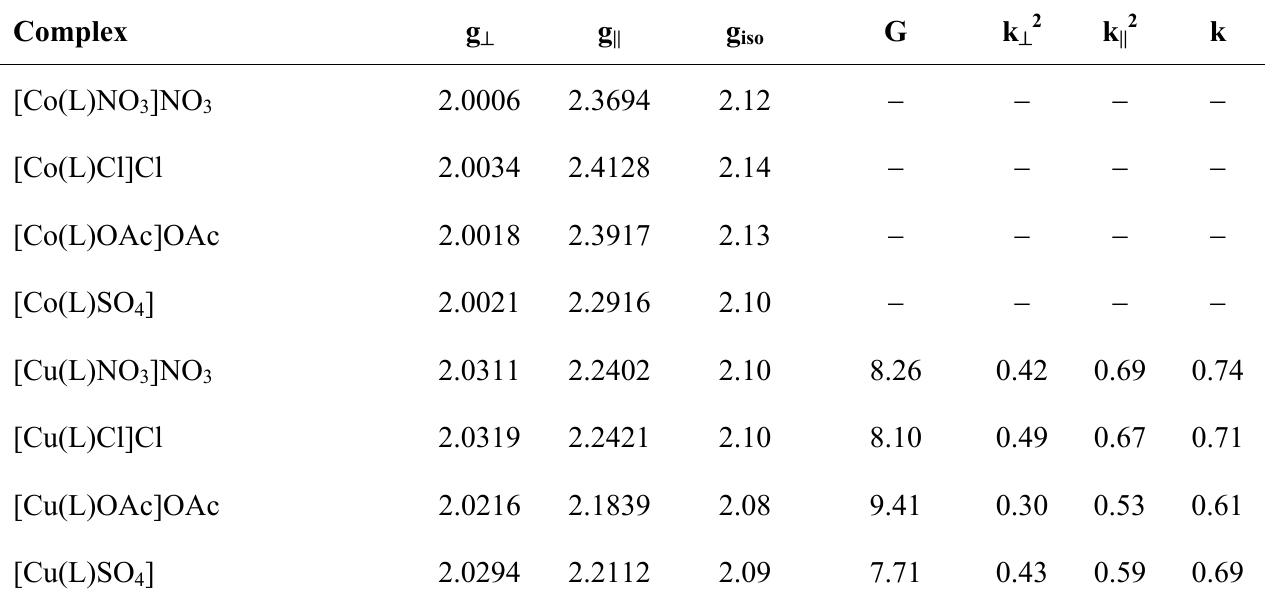
Table 5. EPR parameters and orbital reduction parameters of Co(II) and Cu(II)